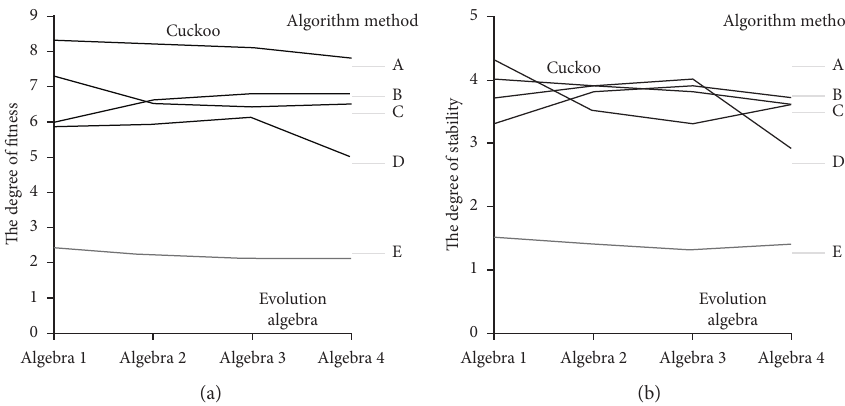
Figure 7: Inversion results of cuckoo search algorithm and other algorithms.